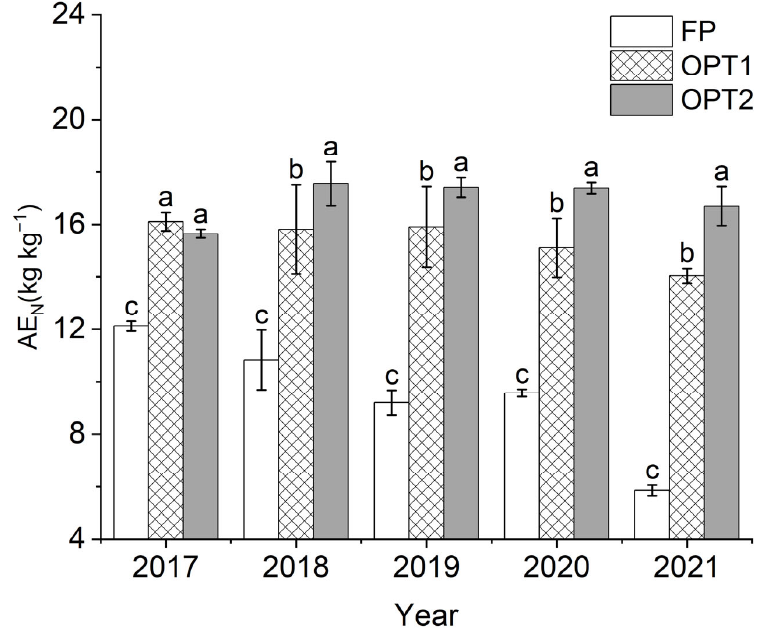
Figure 2. Nitrogen agronomic efficiency of four management systems from 2017 to 2021 in Jingzhou, Hubei Province, China. Means followed by the same letter do not significantly differ (LSD, p < 0.05).